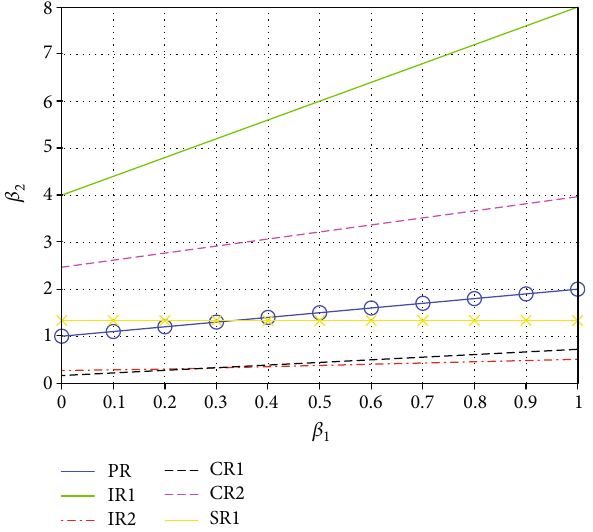
β 1 and 2 under every 2 corresponding to every